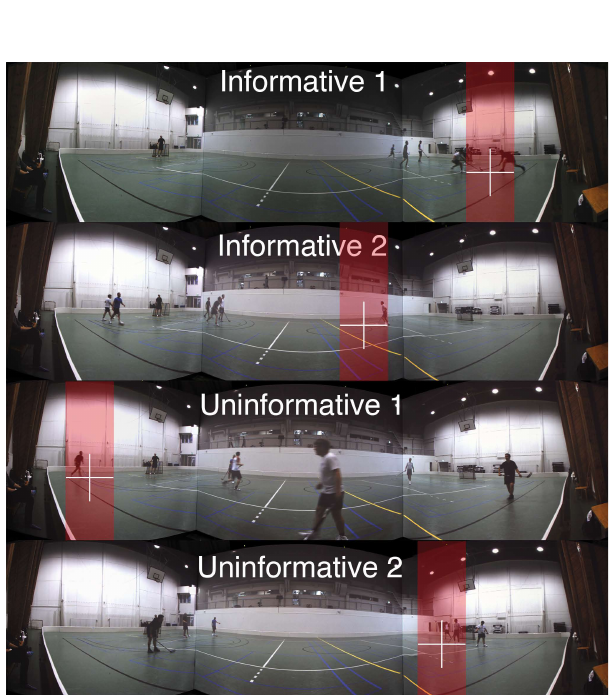
Figure 4 . Areas of interest (AOI) showing the approximate location of the ball during the 5 s floorball scene for each seg- ment. These areas were used in the analysis of the eye track- ing data, as the time to first fixation was calculated according to the participants’ first fixation within the respective AOI in each